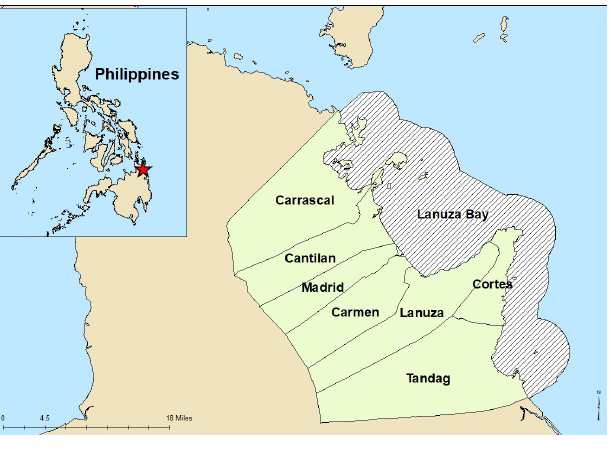
Fig. 1. Map of the Philippines showing the Lanuza Bay Development Alliance focus area (Surigao del Sur, Philippines). Star shows the location of the study area within the Philippines. Source: reproduced from FISH Project (2010a) by Jennifer